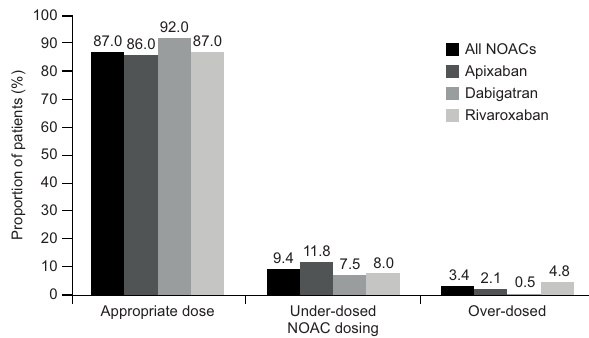
Fig. 1 NOAC dosing by drug in the ORBIT-AF II registry. 24 Rates of NOAC prescription, according to the FDA-approved labels with the appropriate dose, below the appropriate dose (under-dosed) and above the appropriate dose (over-dosed). FDA, U.S. Food and Drug Administration; NOAC, nonvitamin K antagonist oral